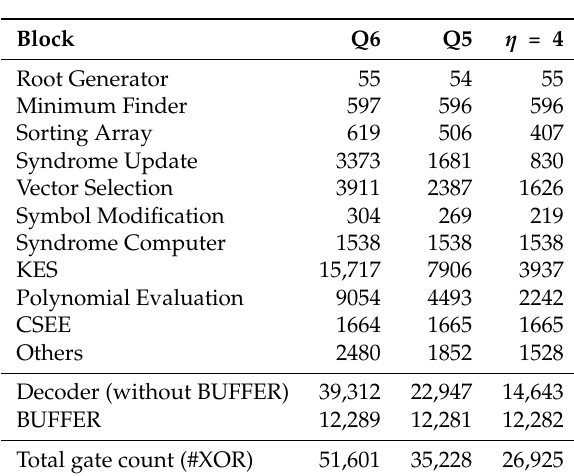
Figure 8. Coding gain at FER = 10 − 6 versus implementation cost (#XORs) for ASIC devices. Note: data from the decoders labeled as ZHA [19], FFD [23] and IBD [24] are estimations and do not include the multiplicity assignment stage. Table 1. Gate count